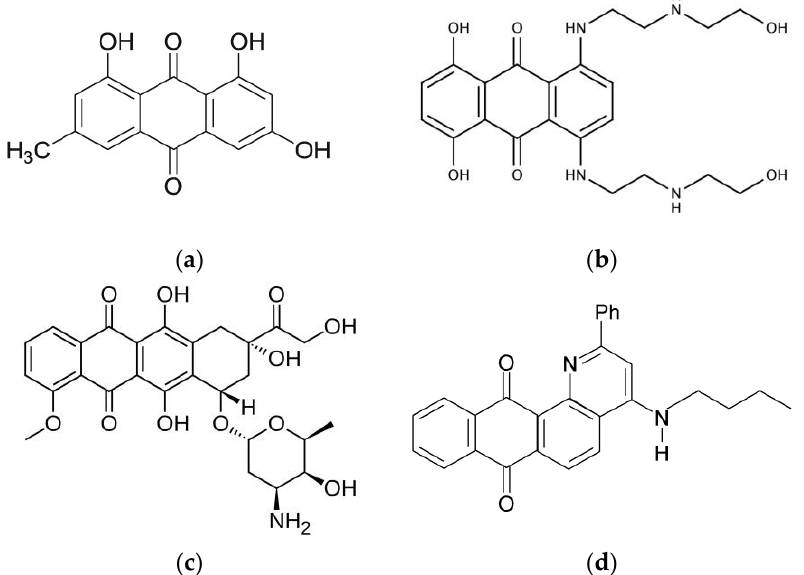
Figure 1. The chemical structures of some anticancer anthraquinones: ( a ) emodin; ( b ) mitoxantrone; ( c ) doxorubicin; and ( d ) anthraquinone Q1 (2-phenyl- 4-(butylamino)naphtho[2,3-h]quinoline-7,12- dione) studied in this work.